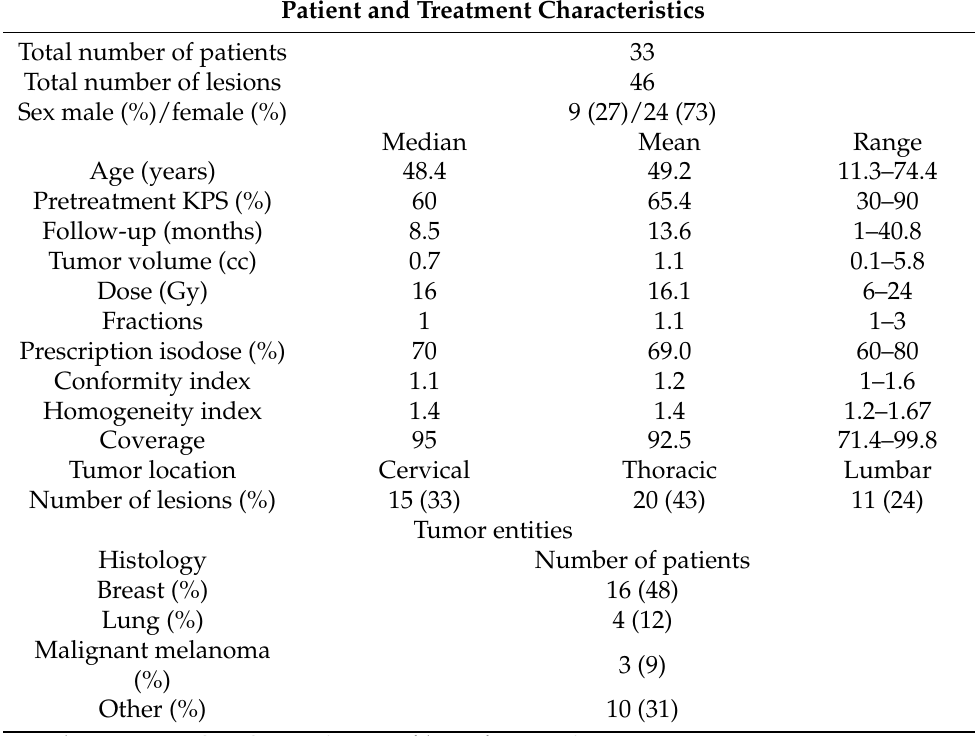
Table 1. Patient and treatment